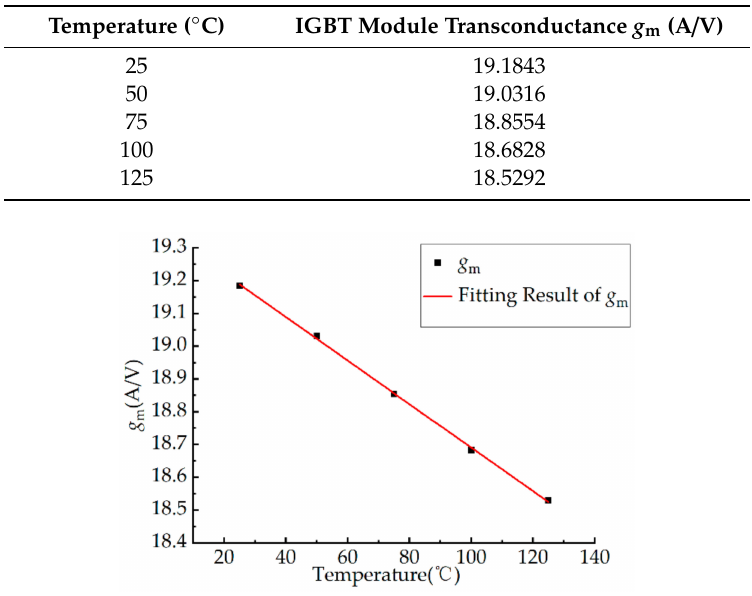
Figure 7. The relationship between IGBT module transconductance and temperature.